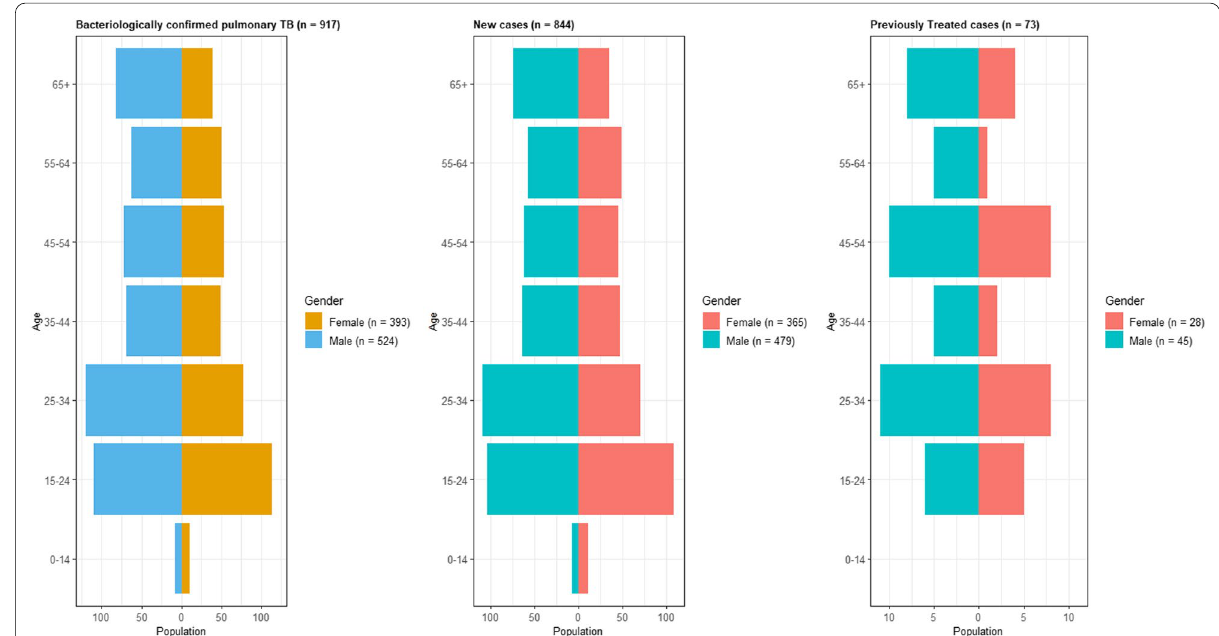
Fig. 2 Age/sex population structure of bacteriologically confirmed pulmonary TB patients